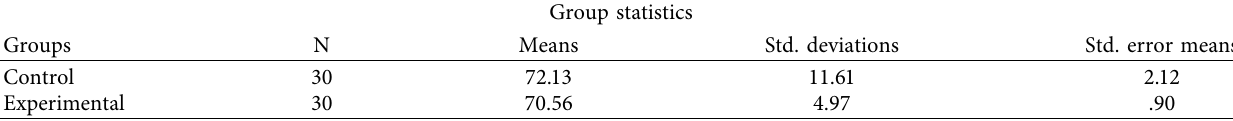
Table 1: Descriptive statistics of the experimental and control groups in the anxiety